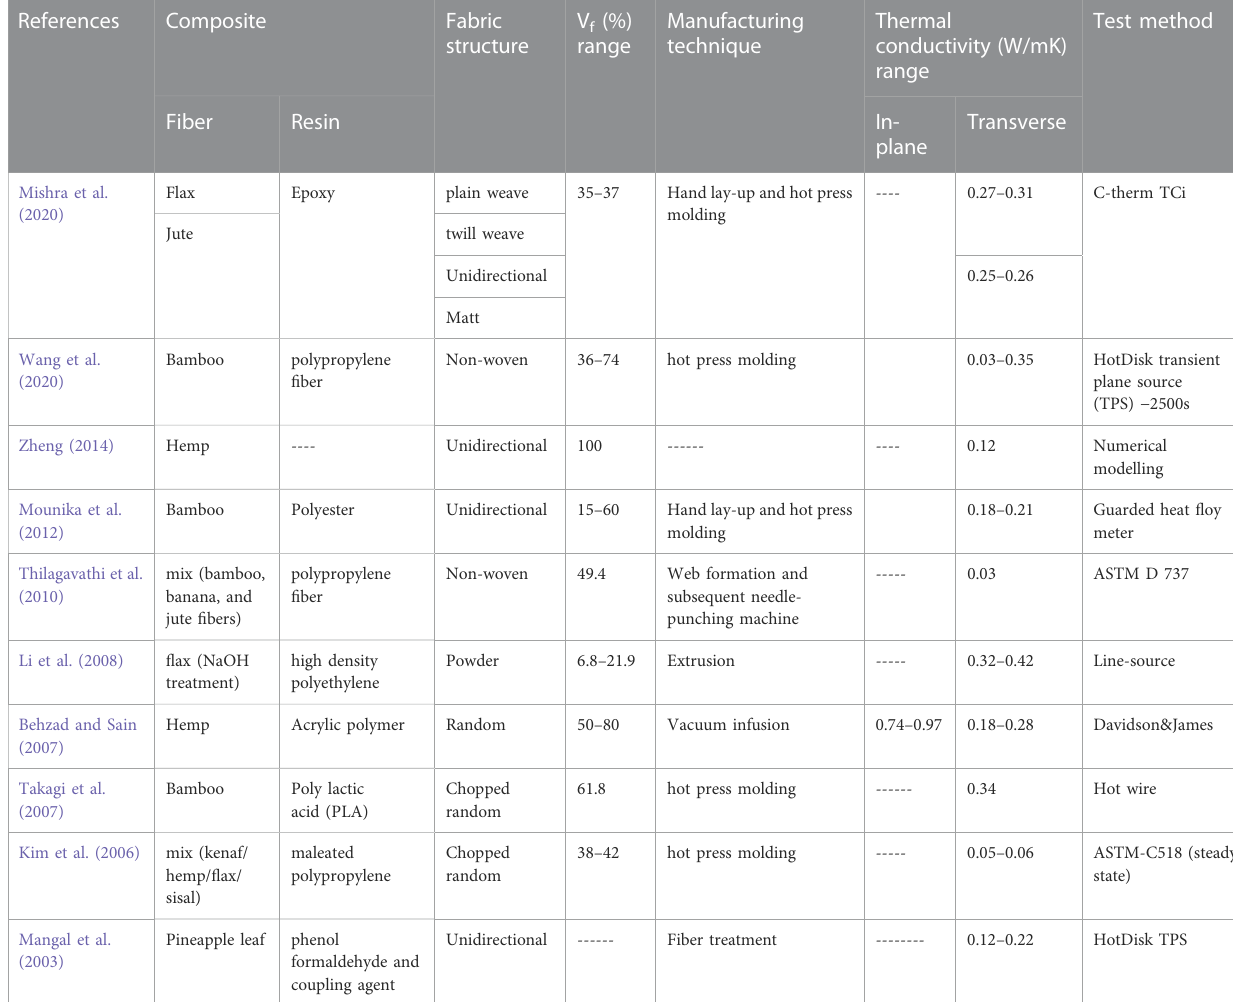
TABLE 1 Experimental study of thermal conductivity measurements of different types of natural fi ber reinforced thermoplastic or thermoset